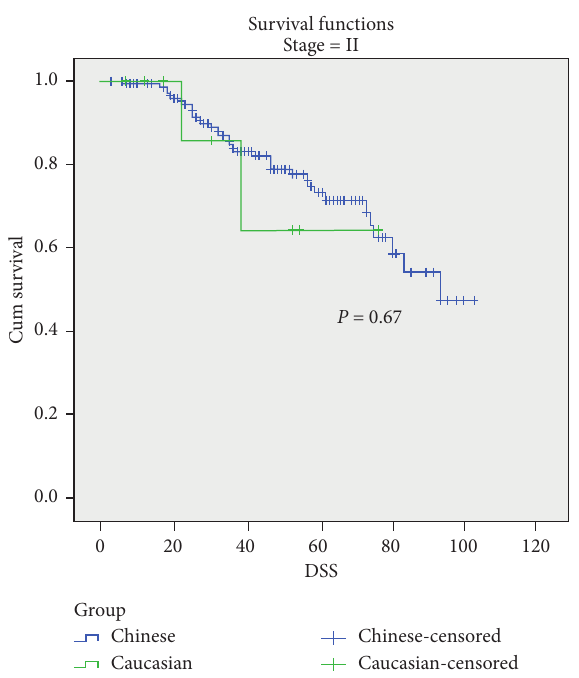
Figure 2: Stage-stratified 5-yr DSS in Chinese and Caucasian groups. Stage II, p � 0 .